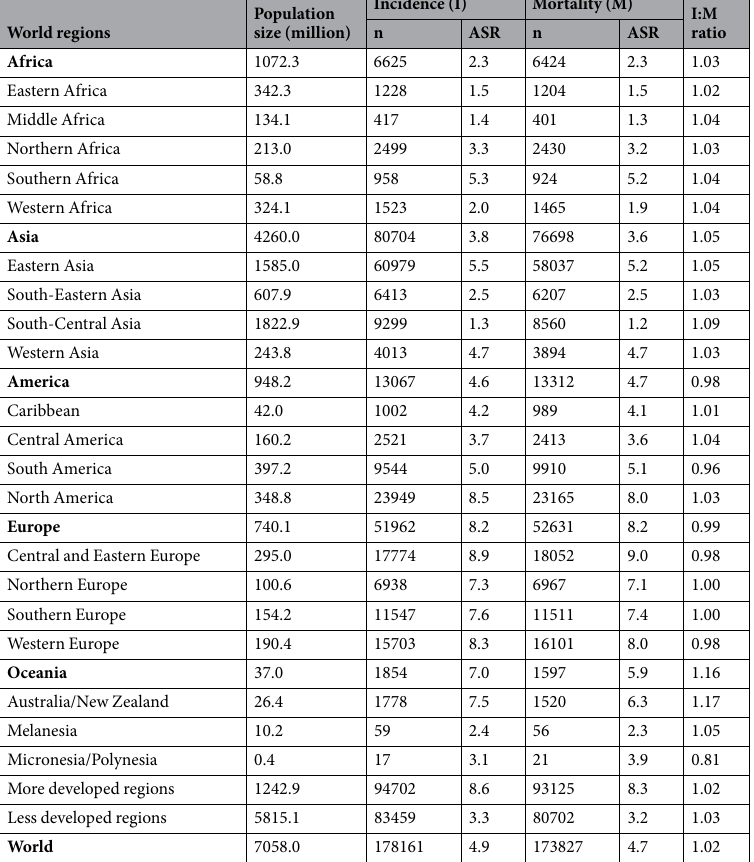
Table 1. The estimated incidence and mortality of pancreatic cancer according to world area, 2012, males. ASR = Age standardized rate per 100,000. Source: GLOBOCAN 2012 [1]. Numbers are rounded to the nearest 10 or 100, and may not add up to the total. The population size of the world regions were retrieved from the Population Reference Bureau, Washington, DC. Available at: http://www.prb.org/Publications/Datasheets/2012/